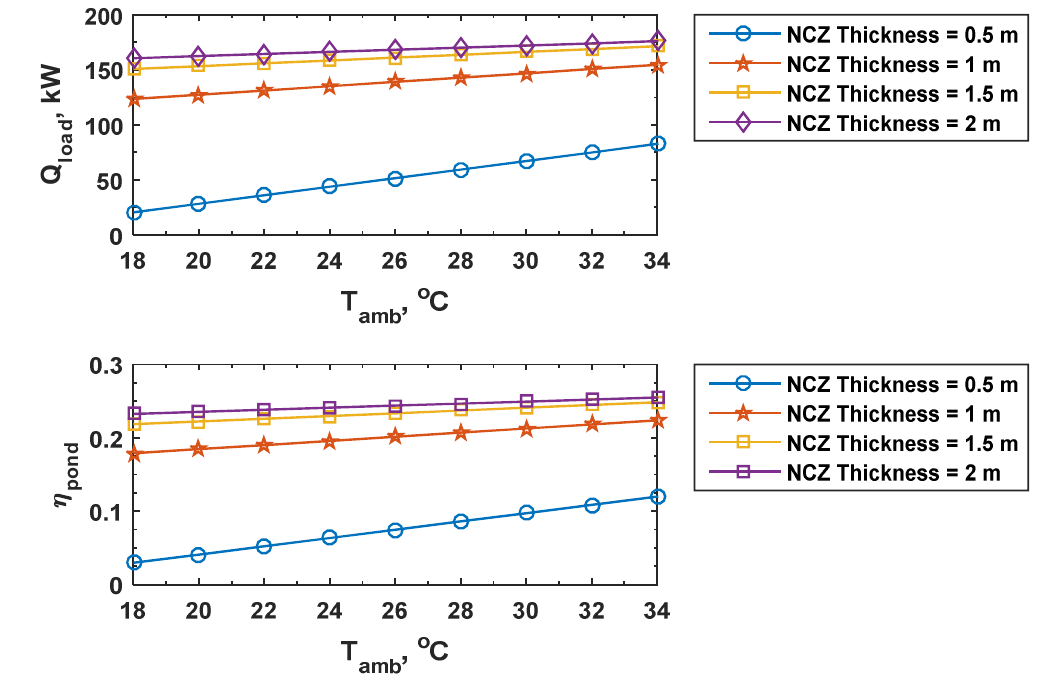
Figure 6. Effect of annual average ambient temperature on the performance of the pond.